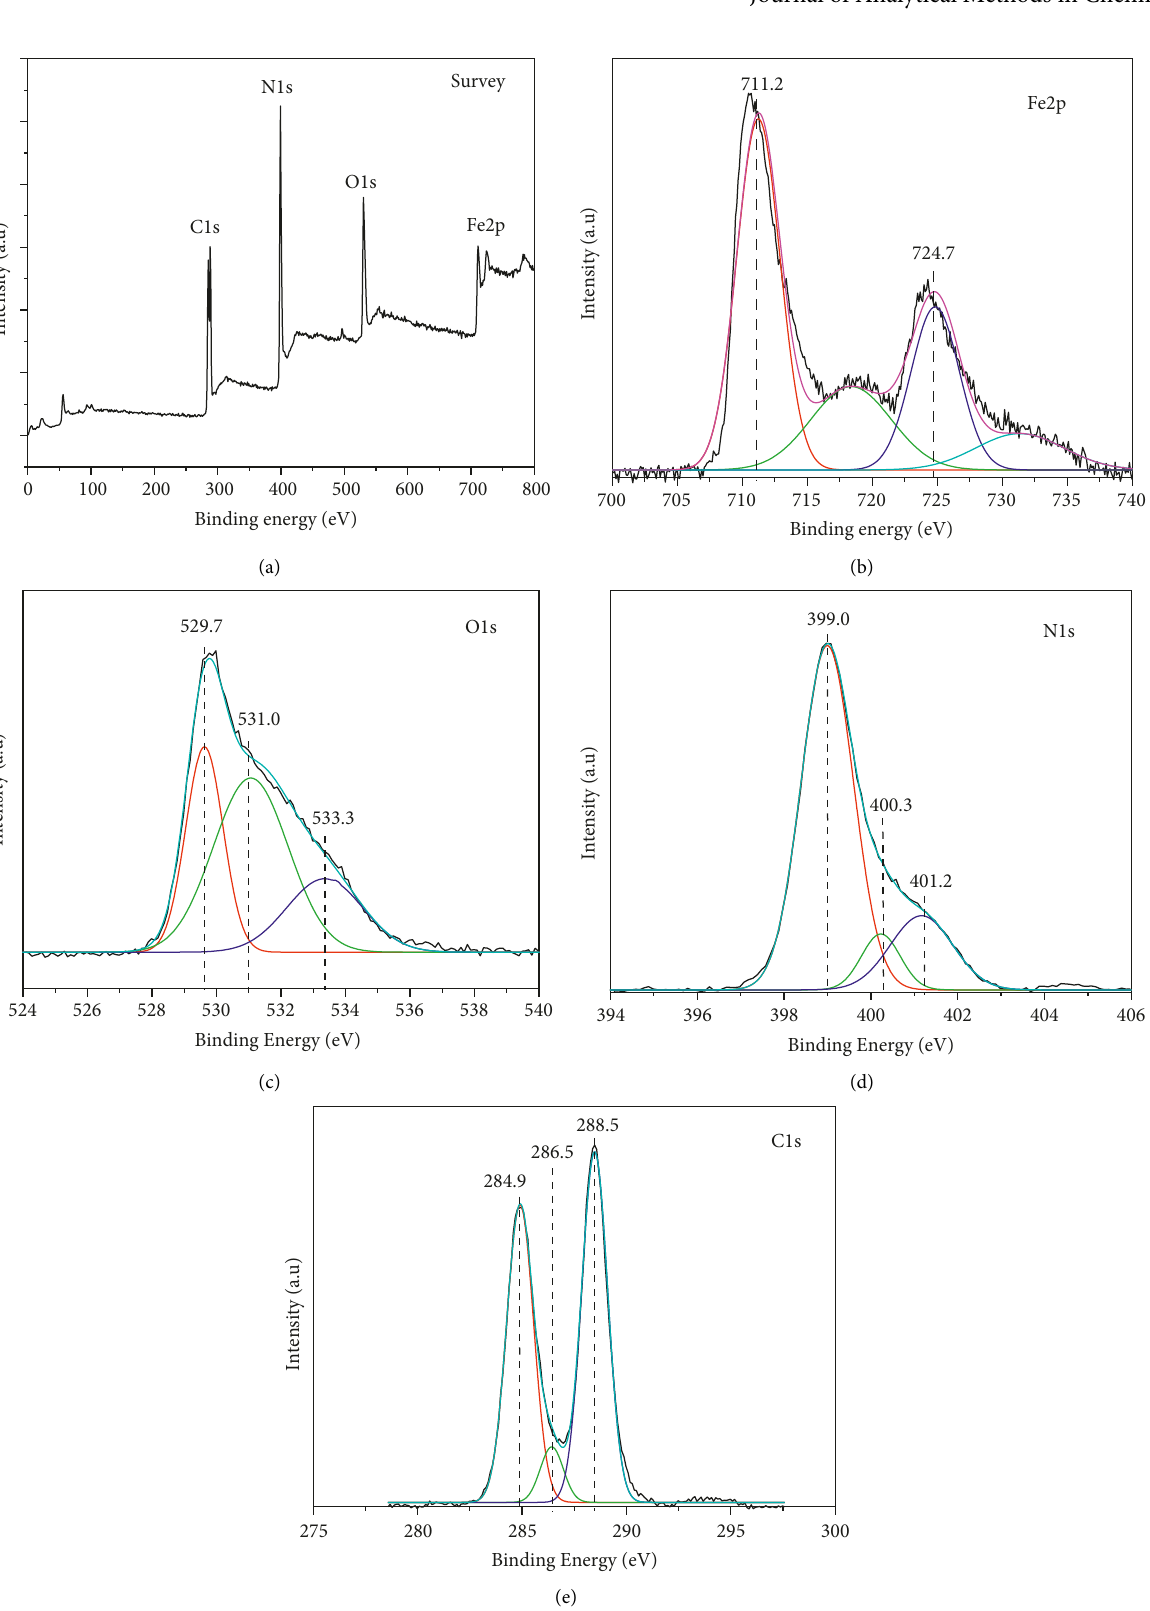
Figure 3: XPS survey of 10FeCN composite (a) and its XPS spectra of Fe2p (b), O1s (c), N1s (d), and C1s